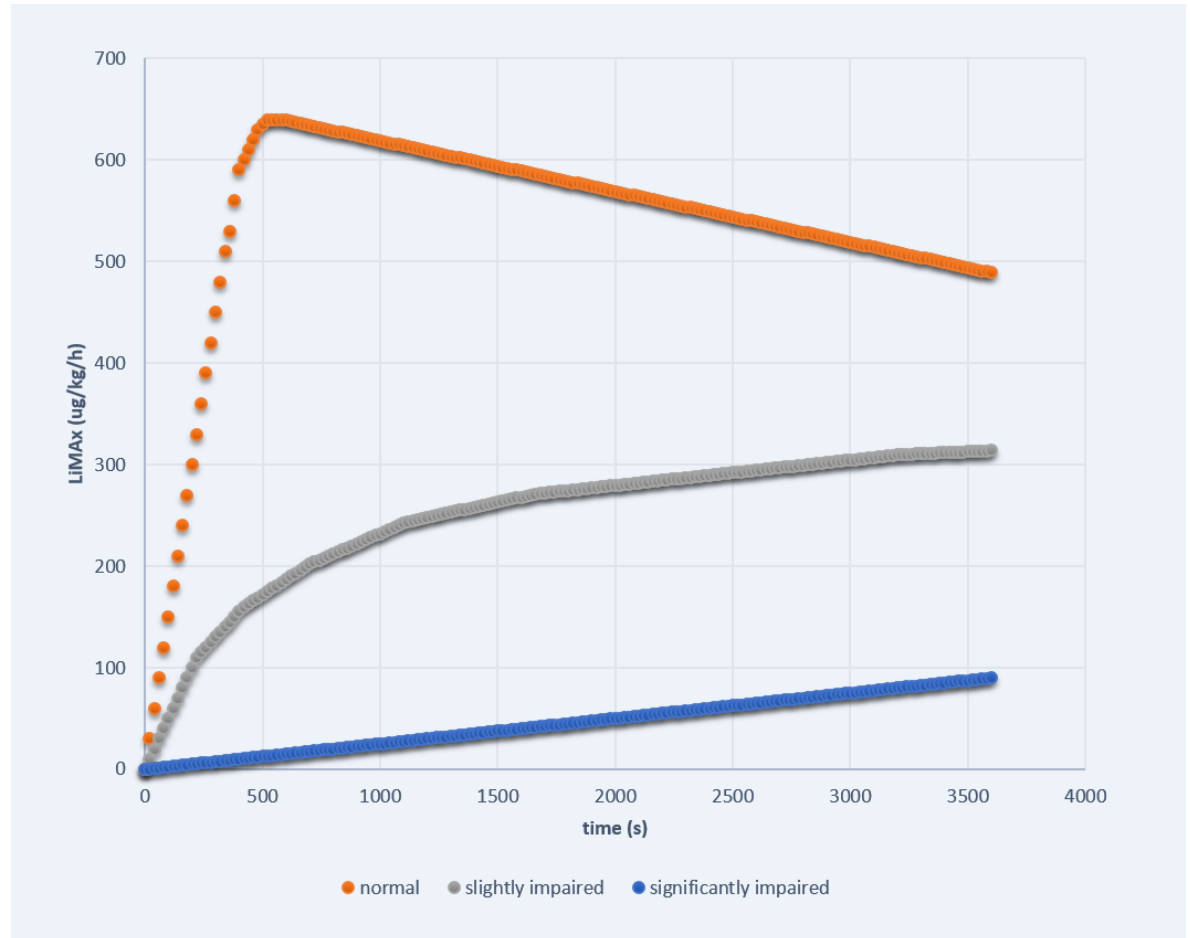
Figure 1. The three different curve kinetics of the LiMAx test.